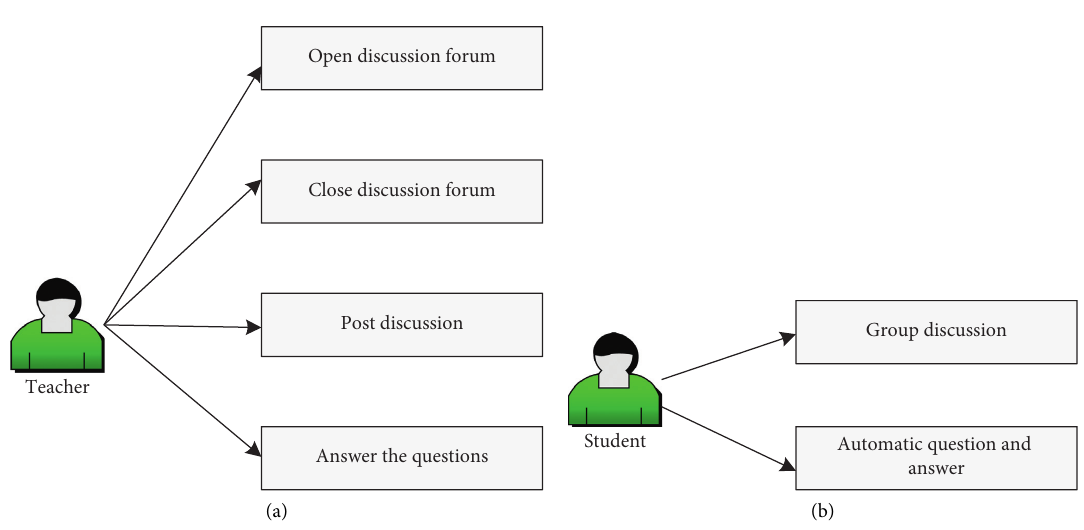
Figure 6: The schematic diagram of the online discussion function for the I&P teaching system.